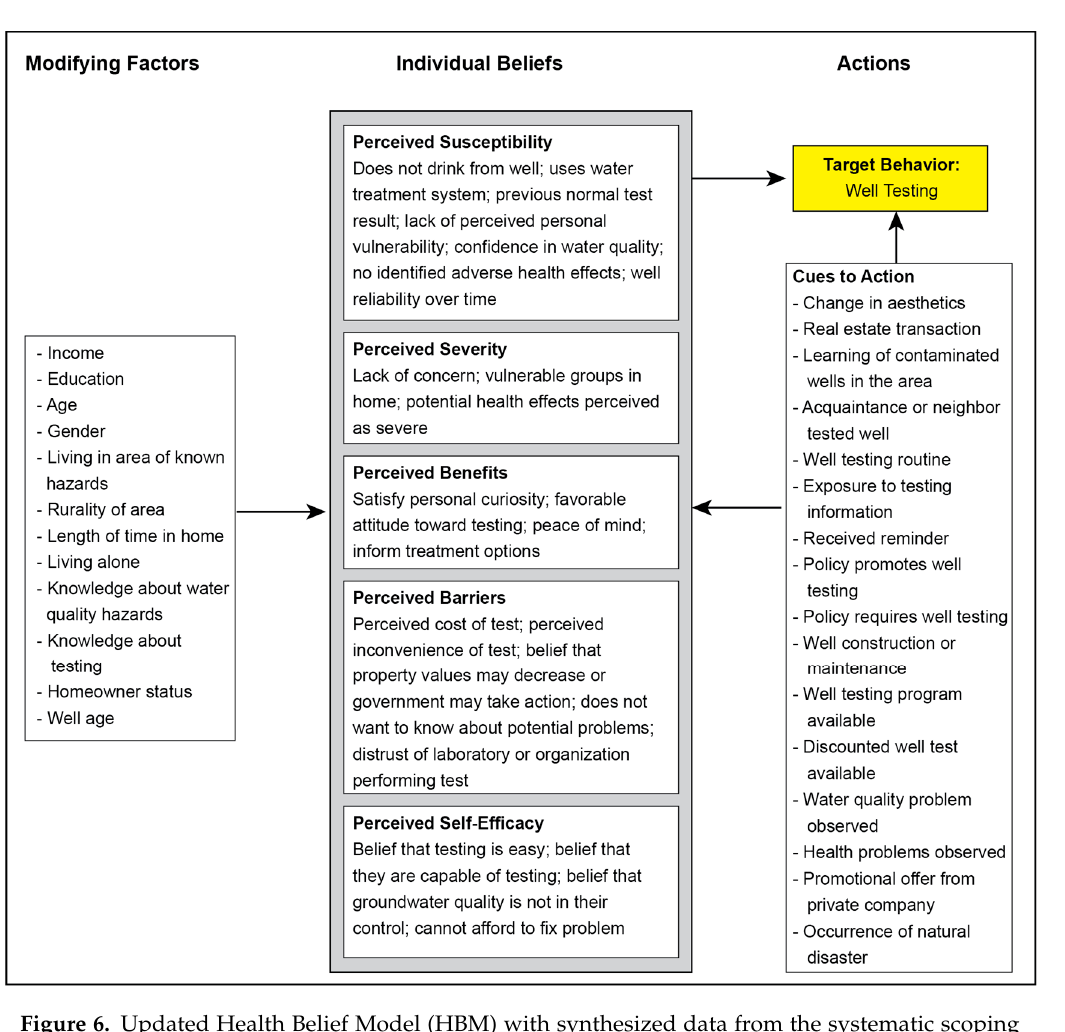
Figure 6. Updated Health Belief Model (HBM) with synthesized data from the systematic scoping review. Source: Adapted from Glanz et al., 2015.